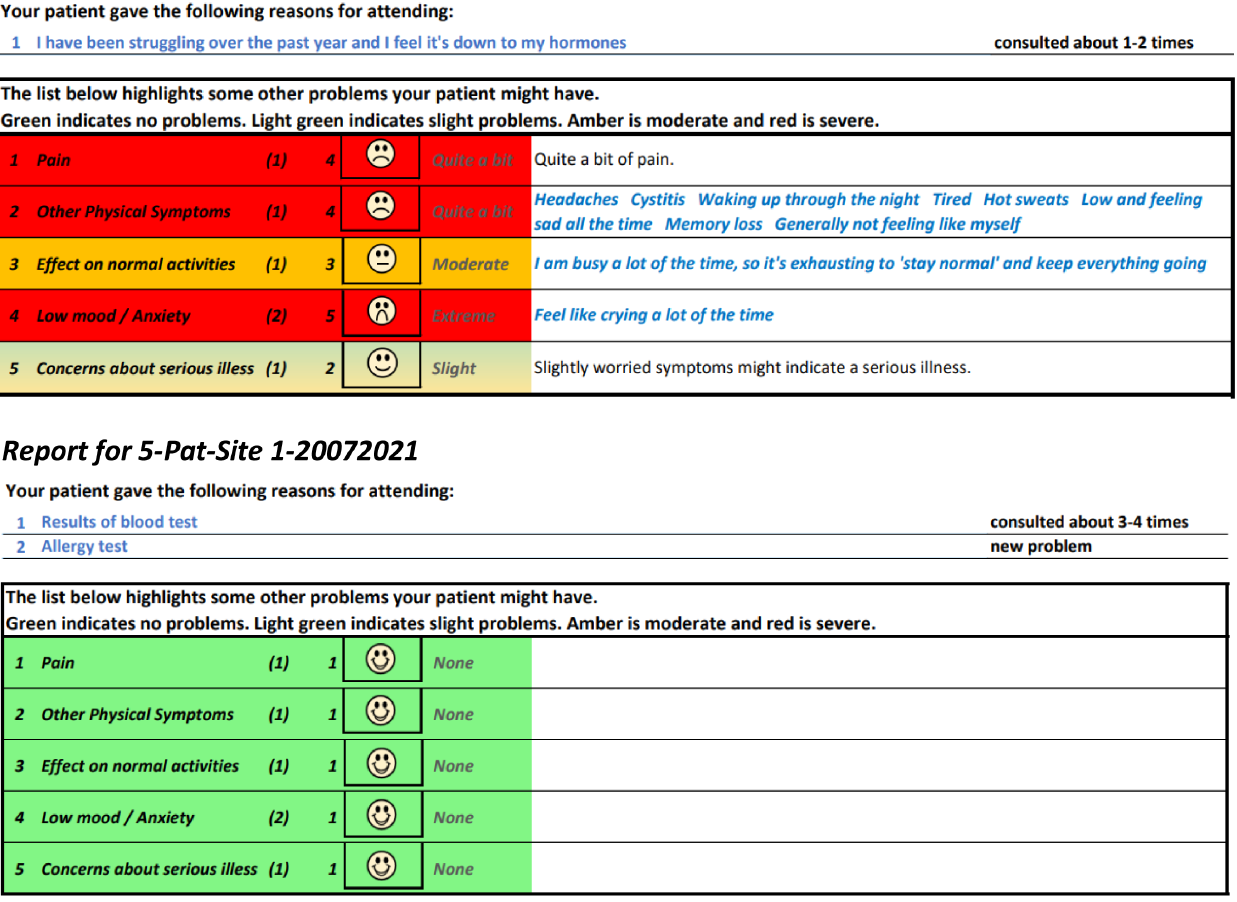
Figure 15. Excerpt of pre-consultation report for different types of